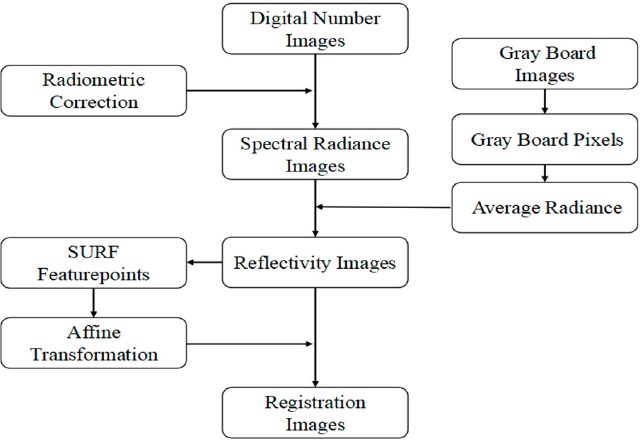
Figure 6. Flow chart of multispectral imagery preprocessing.